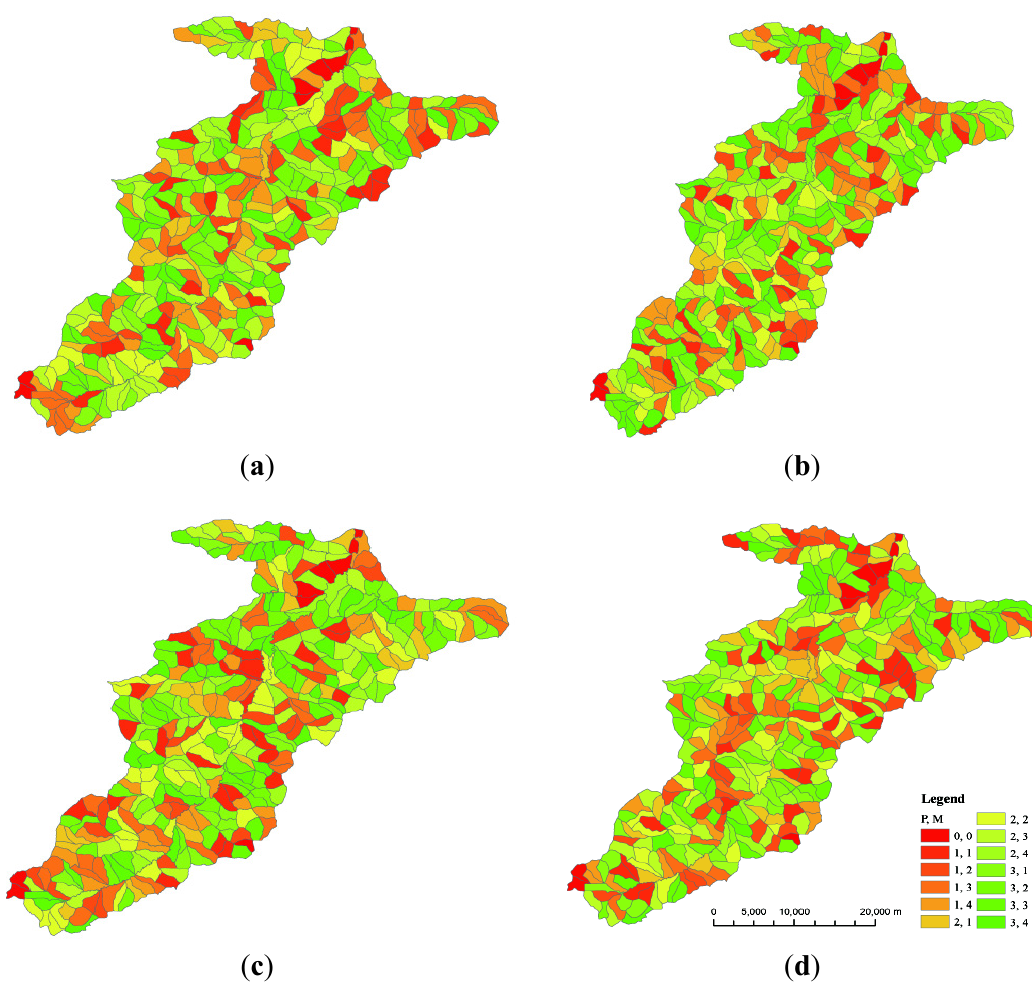
Figure 4. The locations of management activities for forest landscapes with four different age class distributions; ( a ) actual forest; ( b ) young forest; ( c ) normal forest; ( d ) older forest ( Note : P denotes the periods ( P = 1, 2, 3); M denotes the management activities (M = 1, 2, 3, 4), which represent the selective cutting intensities of 0%, 10%, 20% and 30%, respectively; and P = 0 and M = 0 denotes non-forest